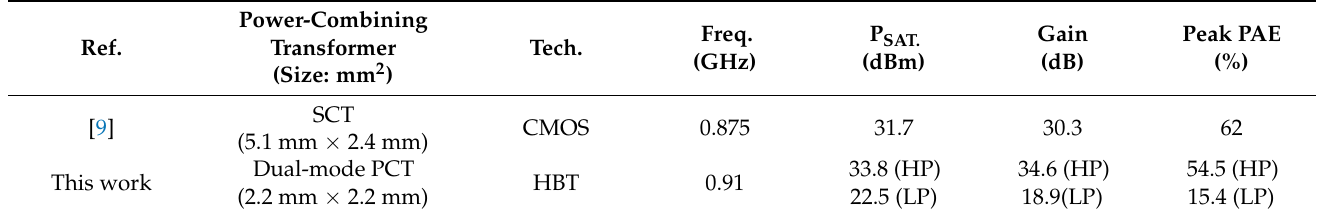
Table 1. Performance comparison of PAs with power-combining transformers on a PCB. Table 2. Performance comparison with linear femto-cell HBT PAs.